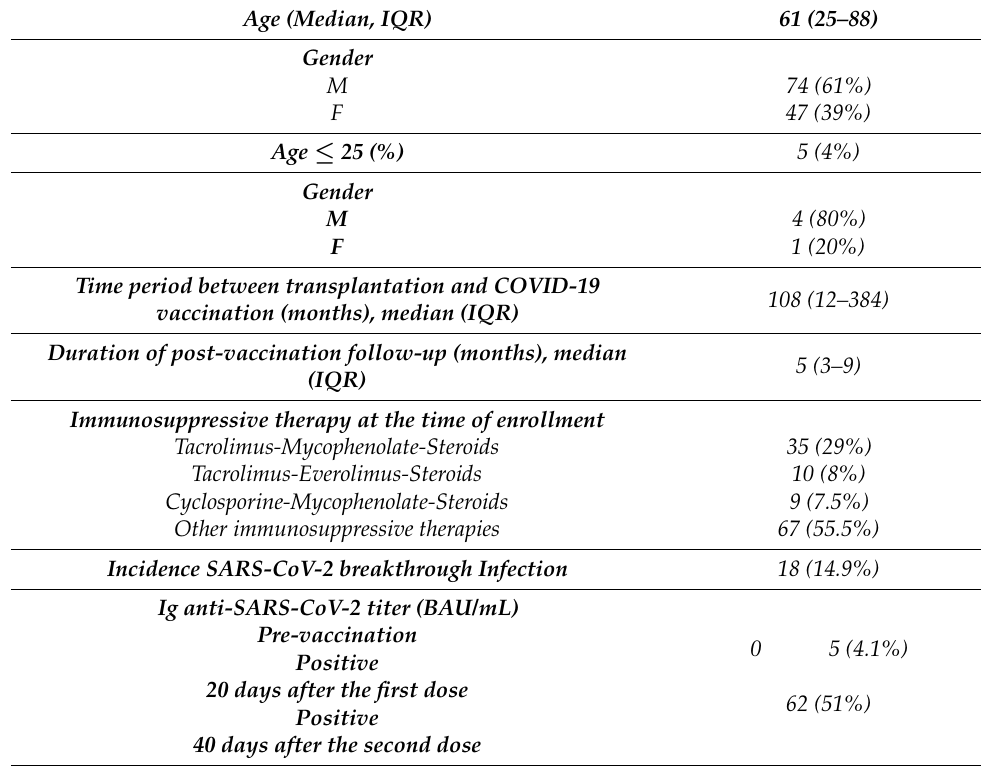
Table 1. Characteristics of enrolled patients (N =